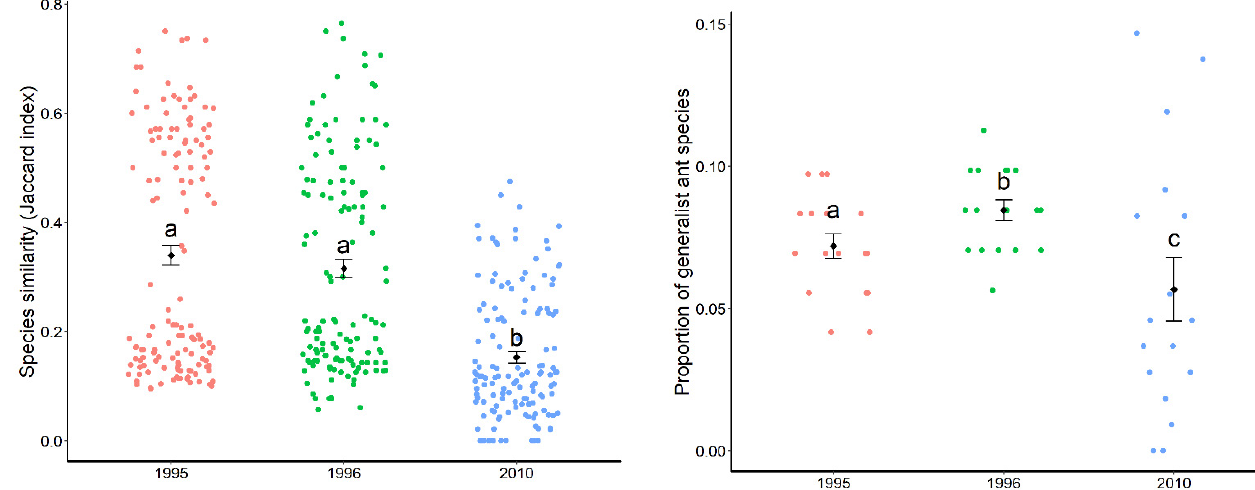
Fig 4. Average proportion of generalist ant species richness across studied fragments, located in southeastern Brazilian Atlantic rain forest. In 2010 it was higher than when compared to 1995 and 1996 (p = 0.01). Points represent the proportion of generalist ant species from each fragment in each year. The black lozenges represent the average and the bars represent the standard error. Different letters represent significant differences at alfa =